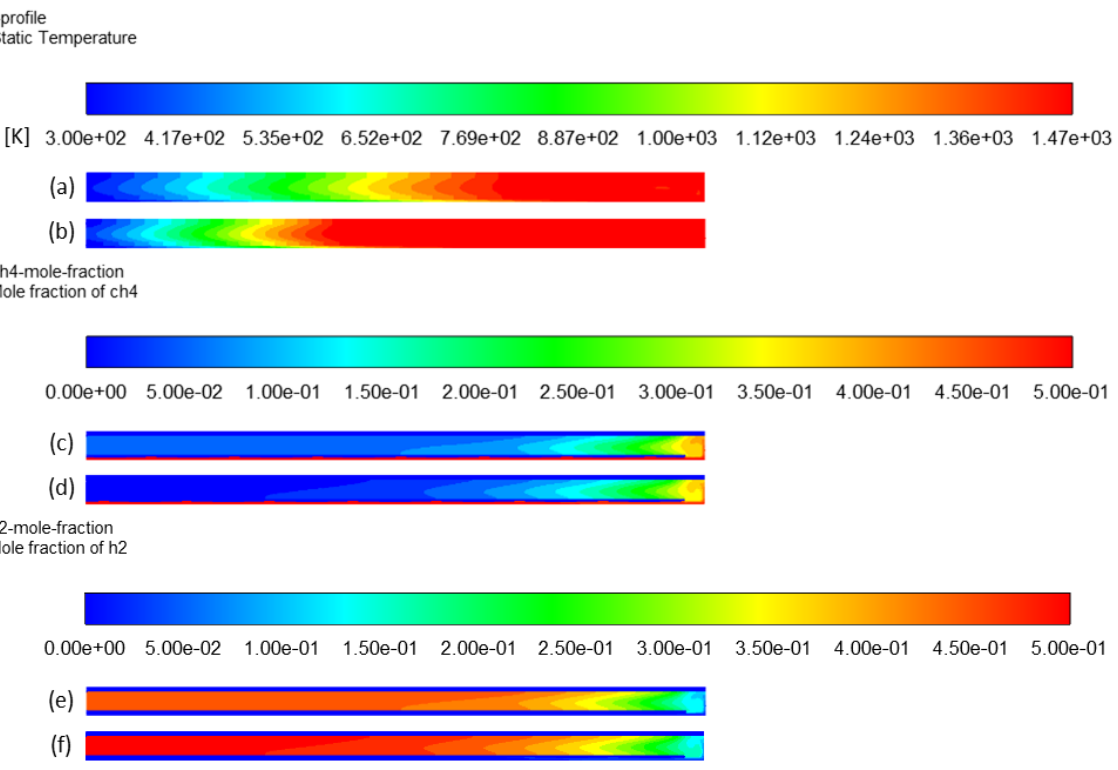
Figure 8. Effect of hybridization on temperature profile: ( a ) case 2 and ( b ) case 1; CH 4 mole fraction profile: ( c ) case 2 and ( d ) case 1; H 2 mole fraction profile: ( e ) case 2 and ( f ) case 1.